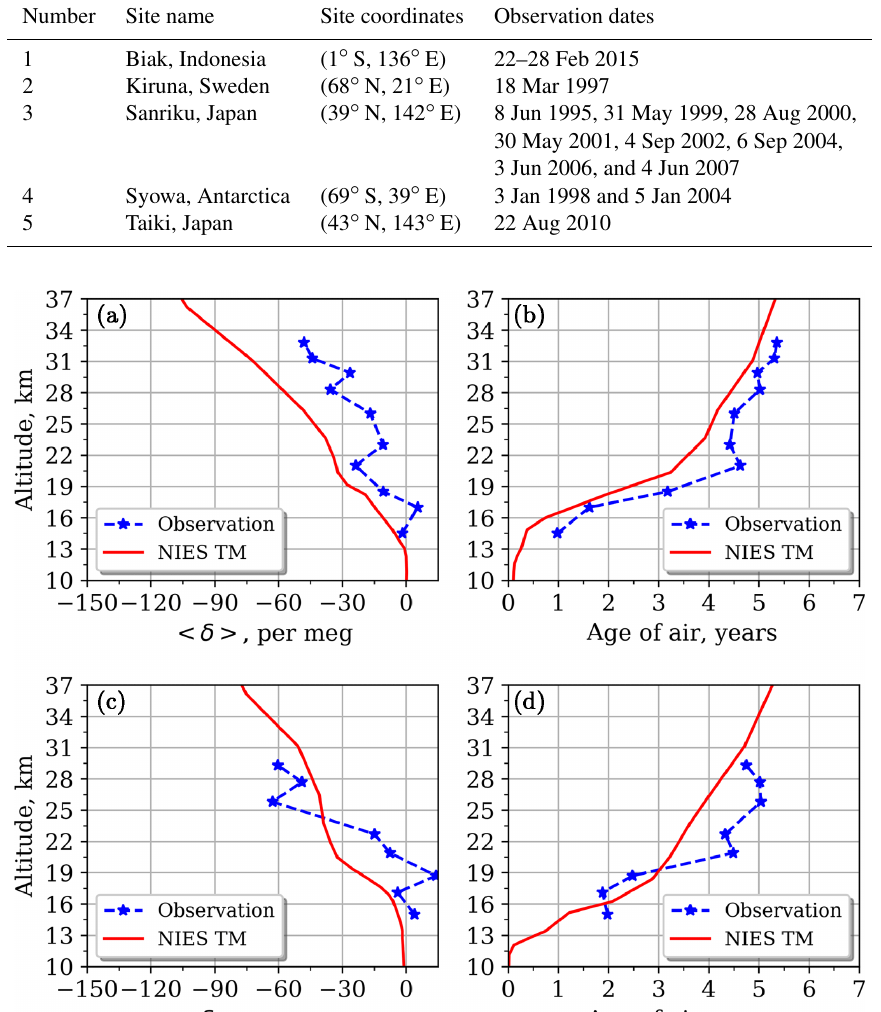
Table 2. Observation sites.